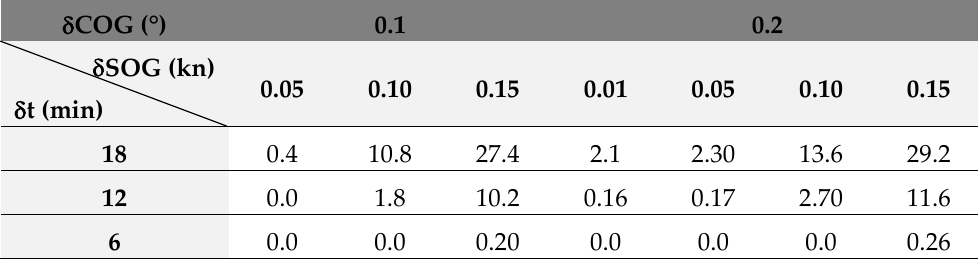
Figure 13. Impact of COG and SOG inaccuracies on the probability of undetected collisions risks dependent, on occurred COG differences ϕ A - ϕ B between both ships (L = 100 m, provided for a forecast time δ t = 18 min, equally distributed SOG values between 0 and 25 kn, and selected standard deviations σ ( δϕ ) and σ ( δ S)). Table 2. Maximum probability of non-detection of existing collision risks for selected standard deviations of SOG and COG inaccuracies (L = 100 m, SOG uniformly distributed between 0 and 25 kn).